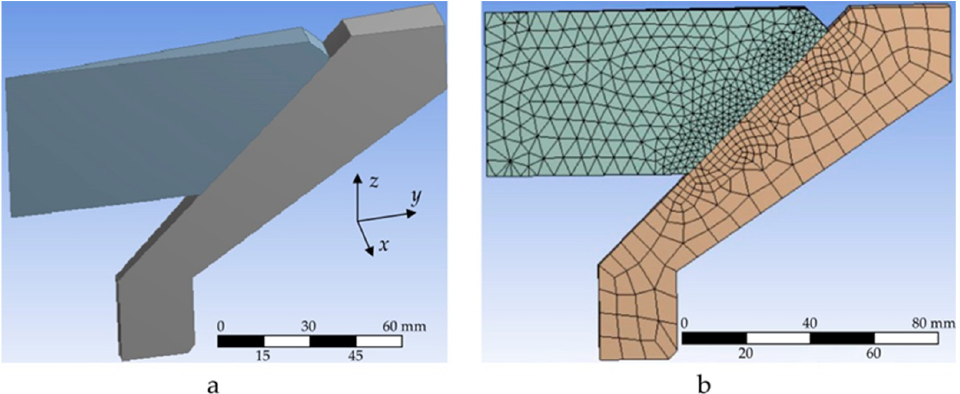
Figure 4. Geometric model Design Modeler ( a ) and finite-element computational model ( b ).